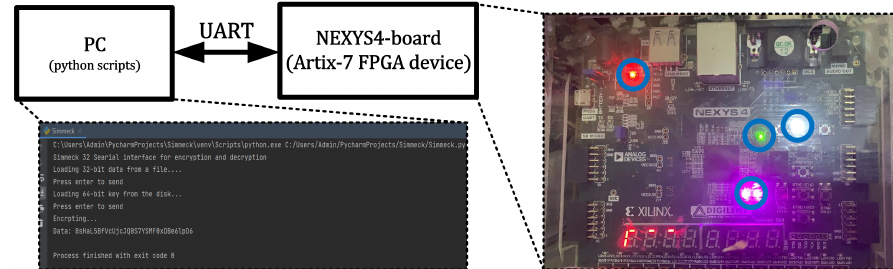
Figure 7. Validation setup using a serial interface of FPGA with the python